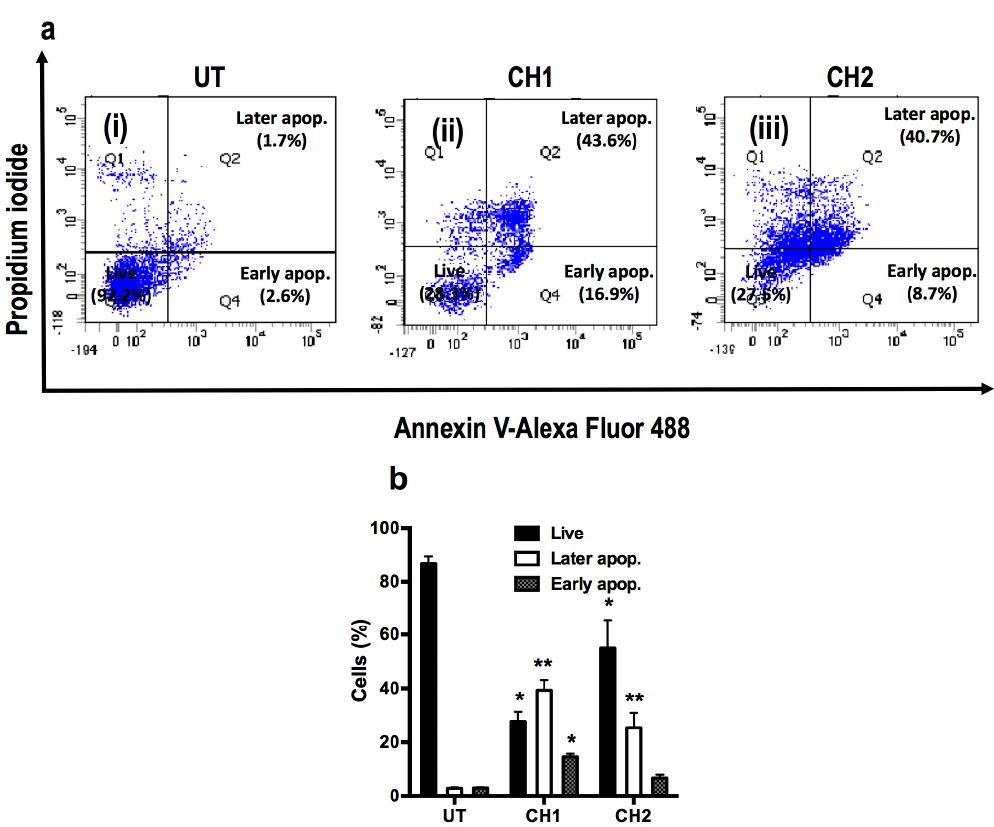
Figure 5. Chalcone-induced apoptosis in HepG2 cells as assayed by flow cytometry. ( a ) HepG2 cells were treated with CH1 and CH2 (50 μ M) for 24 h. The cells were then harvested and stained with Annexin V and PI and flow cytometric analysis was performed to analyze the apoptosis; ( b ) Summary of the apoptosis data in histogram form. Data are expressed as the mean ± standard error of the mean (SEM) from at least three independent experiments. * p < 0.05 vs. the untreated (UT) group; ** p < 0.01 vs. the untreated group.